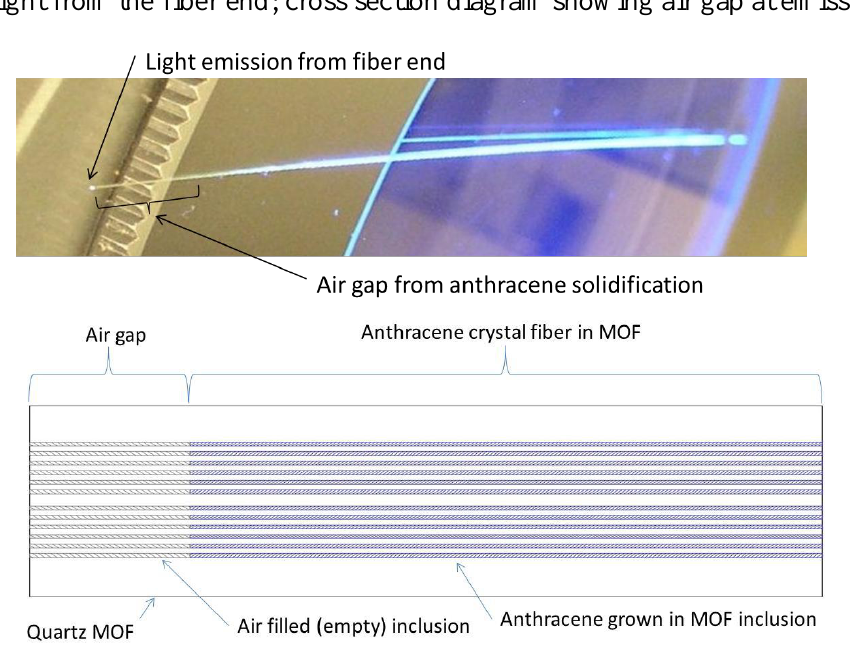
Figure 4. Anthracene in MOF: shown on a microscope stage illuminated with 385 nm UV light showing the air gap formed from solidification during the growth process and blue (420 nm) light from the fiber end; cross section diagram showing air gap at emission end.